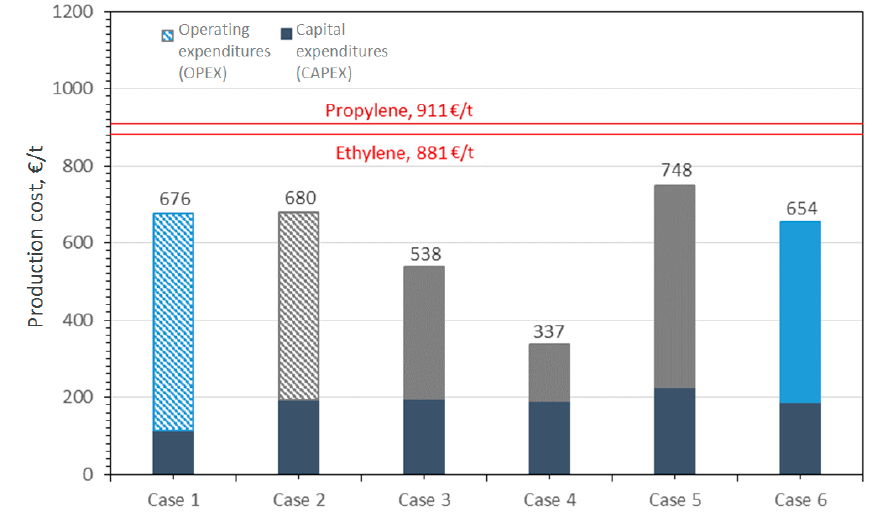
Figure 14. CO 2 emissions—olefins production (coal gasification, 2030/2050).